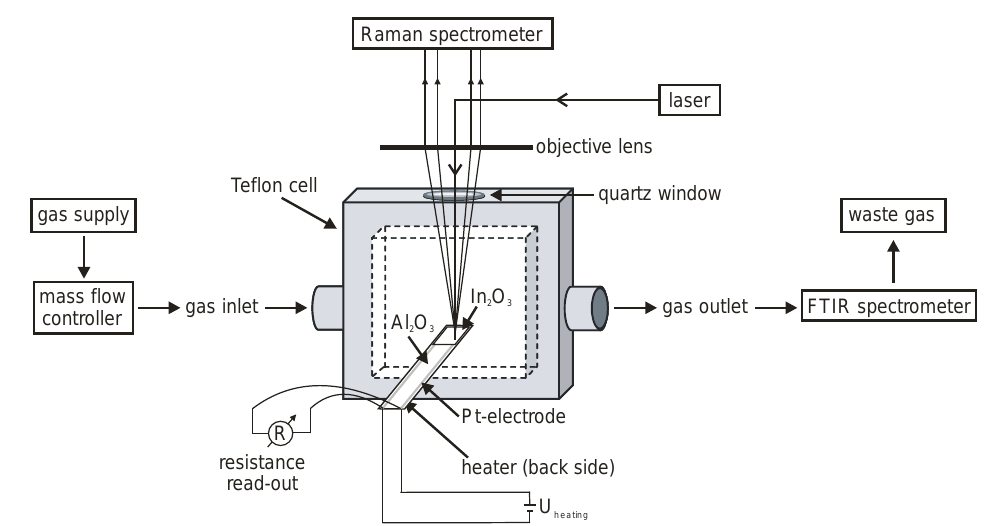
Figure 2. Operando Raman spectroscopic setup for simultaneous measurement of the sensor response (dc electrical conductivity), Raman spectra of the sensor material and FT-IR spectra of the gas-phase composition. Reproduced from [5].